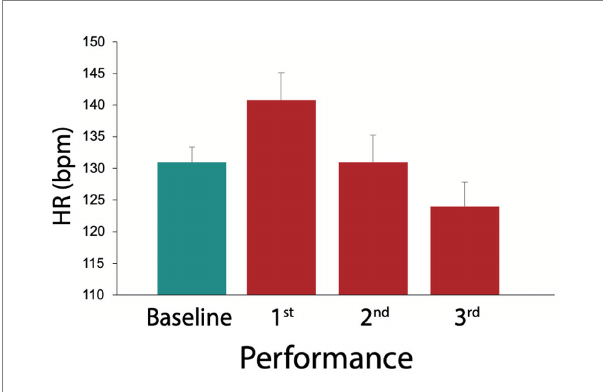
FIGURE 1 Heart rate (HR). HR changes from baseline to 3rd performance. Baseline (green) consisted of a 1 min run with hopping on the spot. Bars 2 to 4 (red) show HR during on-stage performance from 1st to 3rd performance. Shown are means and standard error (S.E.) of